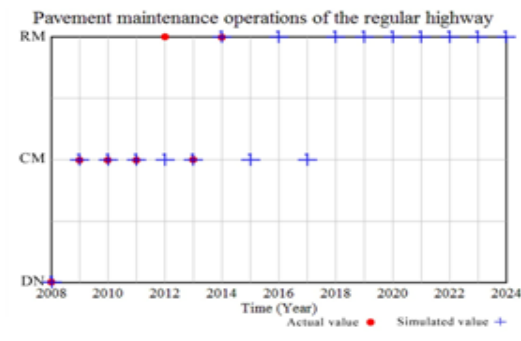
Figure 3. Model validation on the pavement maintenance operations of the regular highway